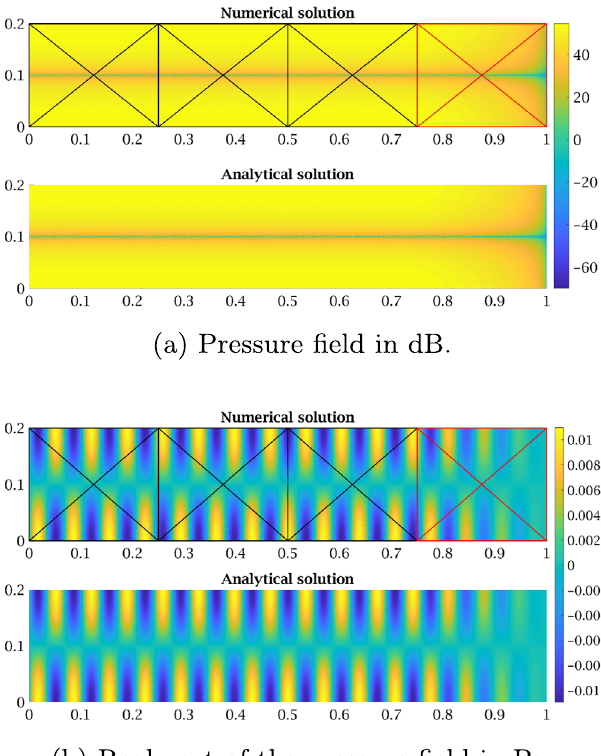
Figure 5. Pressure fi eld for n = 1 at 5000 Hz with C = 12. Black lines: acoustic domain mesh; red lines: PML domain